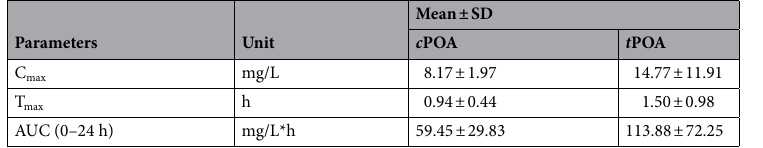
Table 5. Pharmacokinetic parameters of baseline-corrected c POA and t POA in rats after i.g. administration of c POA and t POA at 75 mg/kg body weight.